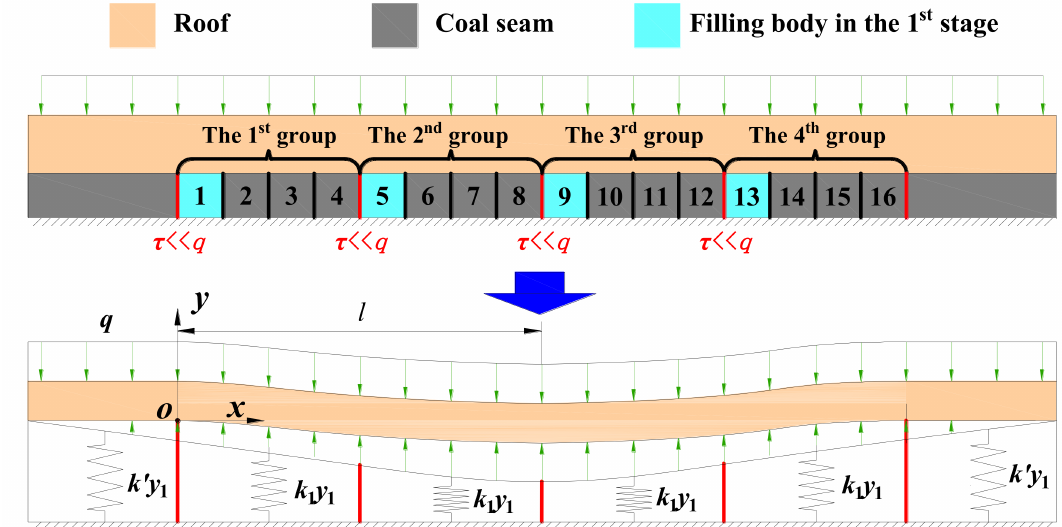
Figure 6. The mechanical model of roof sinking in the first stage of using the CECB